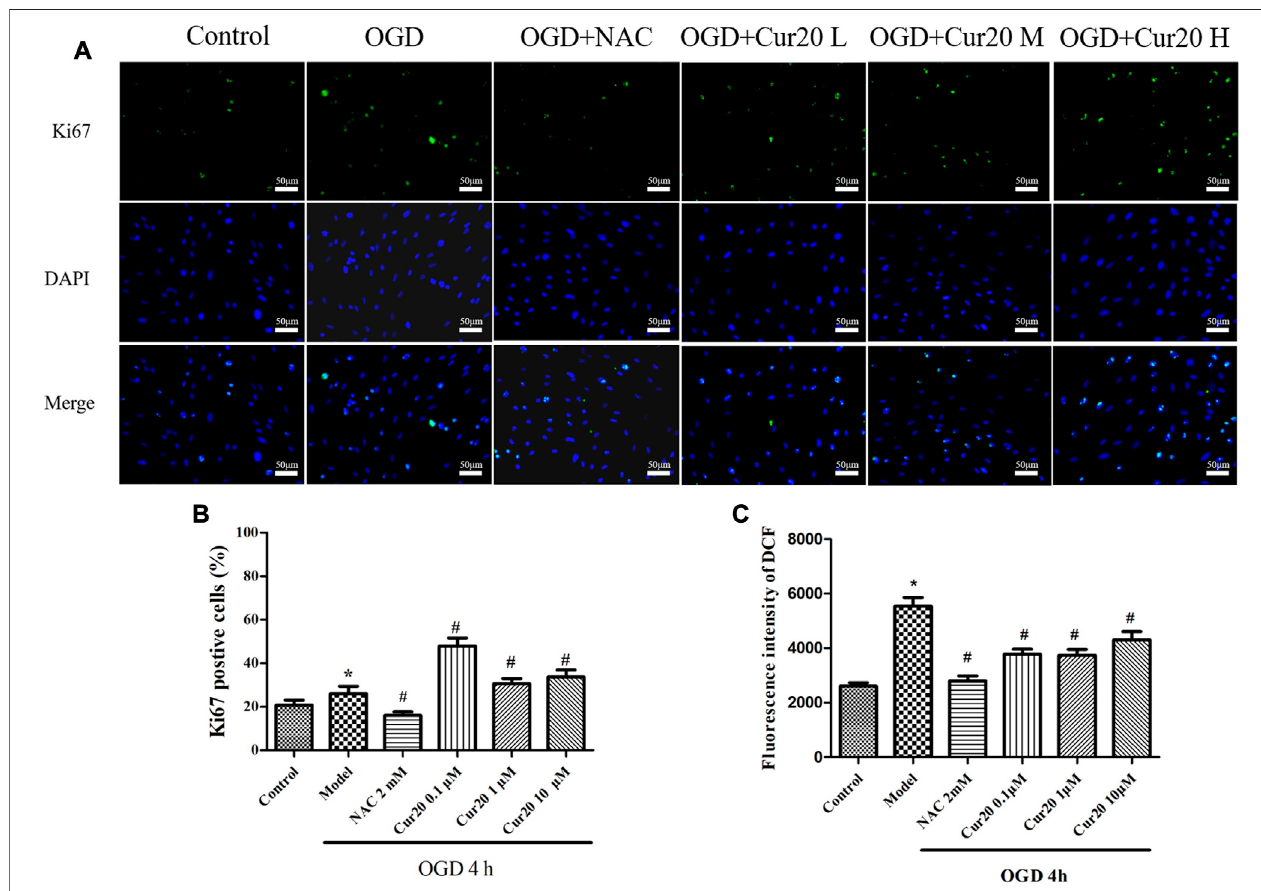
FIGURE 8 | Effectof Cur20 on the proliferation of rBMECs after treatment with OGD for 4 h and cultivated for another 24 h A – B , Immuno fl uorescence wasutilized to observe the positive stain of Ki67 (200 × ). C , DCFH-DA was used to detect the intracellular ROS level. The experimental data was expressed by mean ± SD, n (cid:2) 3. * p < 0.05 vs. Control group, # p < 0.05 vs. Model